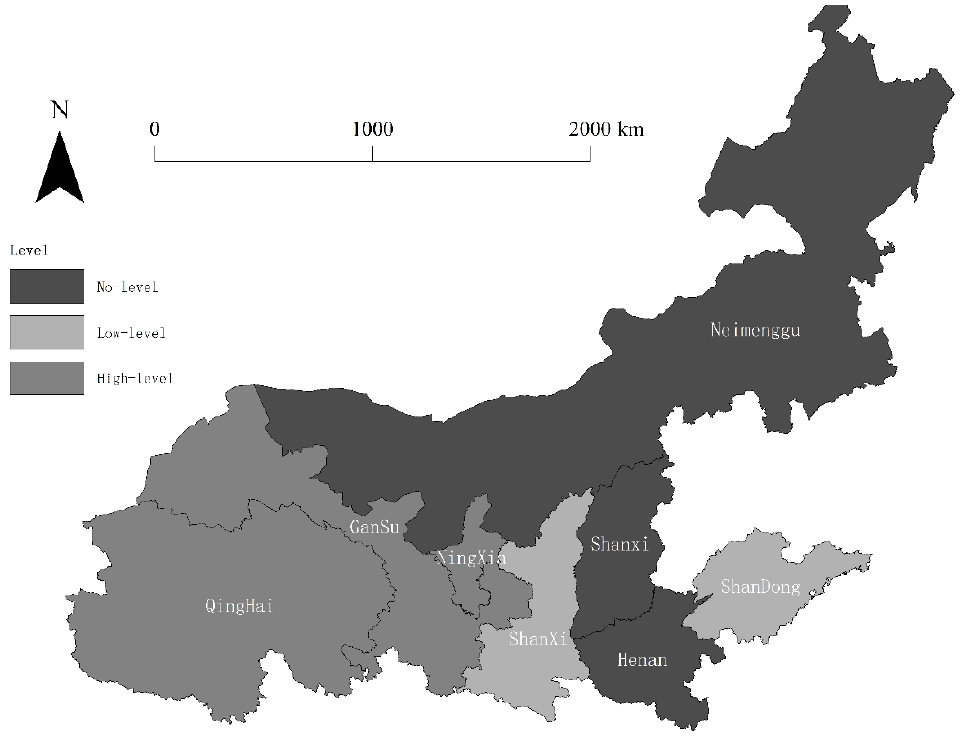
Figure 2. Local correlation diagram of uncoordinated coupling degree in the Yellow River Basin. Note: This map was made based on the standard map (GS(2020)4634) downloaded from the standard map service website of the National Administration of Surveying, Mapping, and Geographic Information. The base map has not been modified.